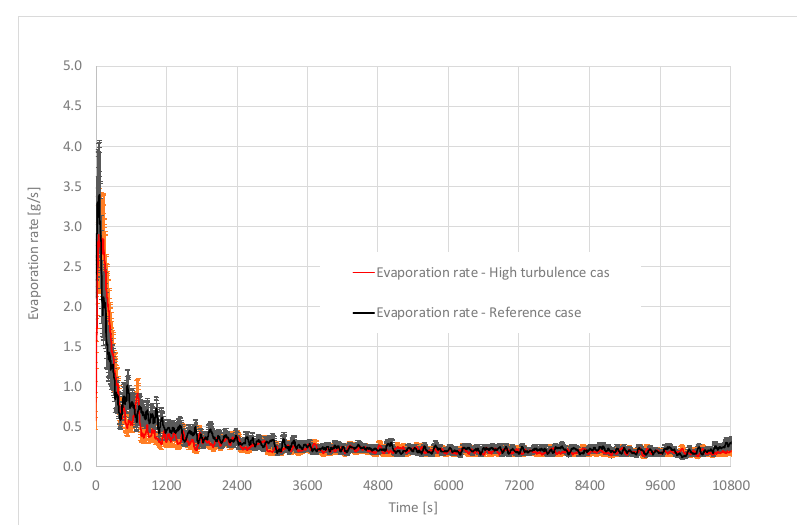
Figure 13. Influence of local upstream turbulence on the evaporation rate.